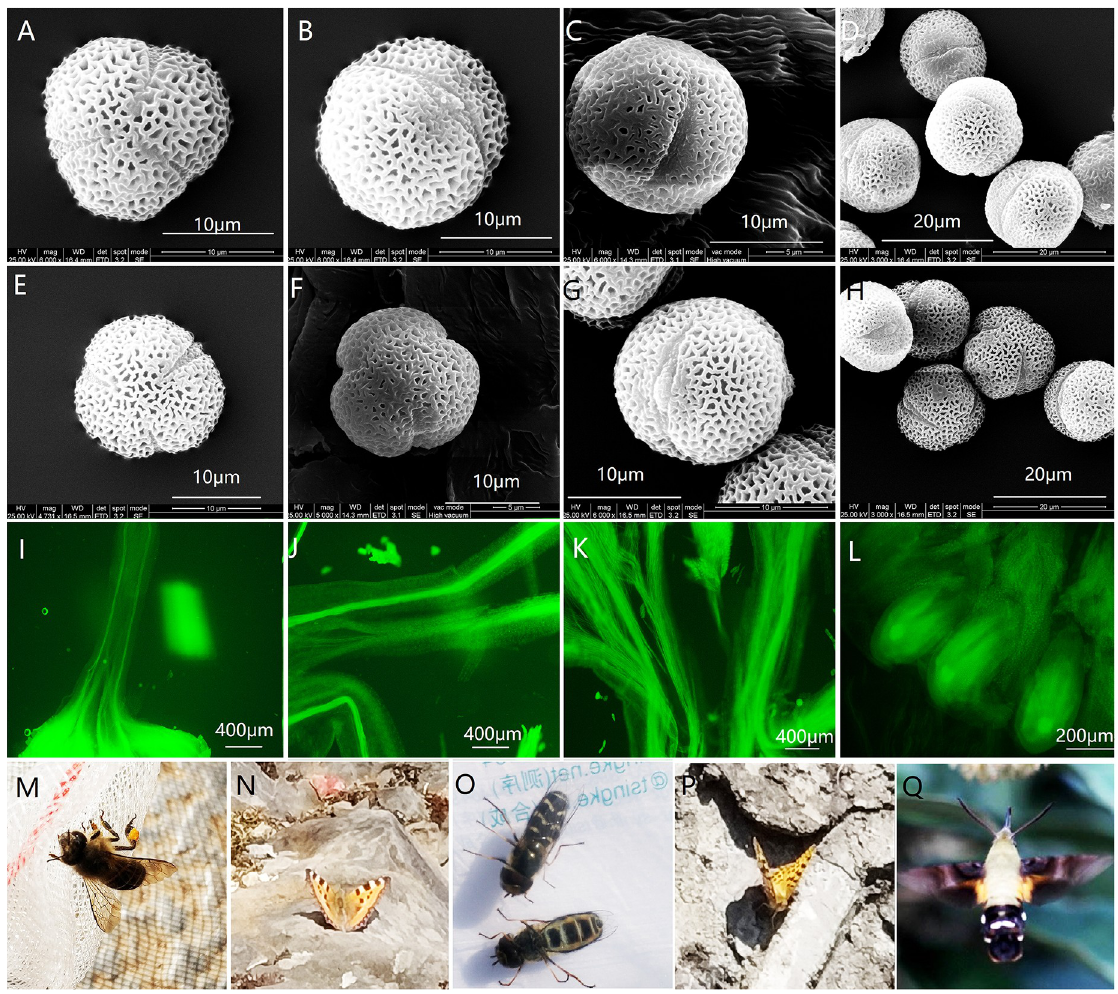
Fig 4. SEM micrographs of pollen characteristics, FM micrographs of pollen tube germination, and pollinators of O . delavayi . Note: (A-D) Hermaphrodite. (E-H) Male. (I) Pollen tube of self-pollinating hermaphrodite pollen. (J) Pollen tube of outcrossing hermaphrodite pollen. (K) Pollen tube of male pollen. (L) Fertilized ovule. (M-Q) Pollinators: Apis andreniformis Smith., Nymphalis xanthomelas ,